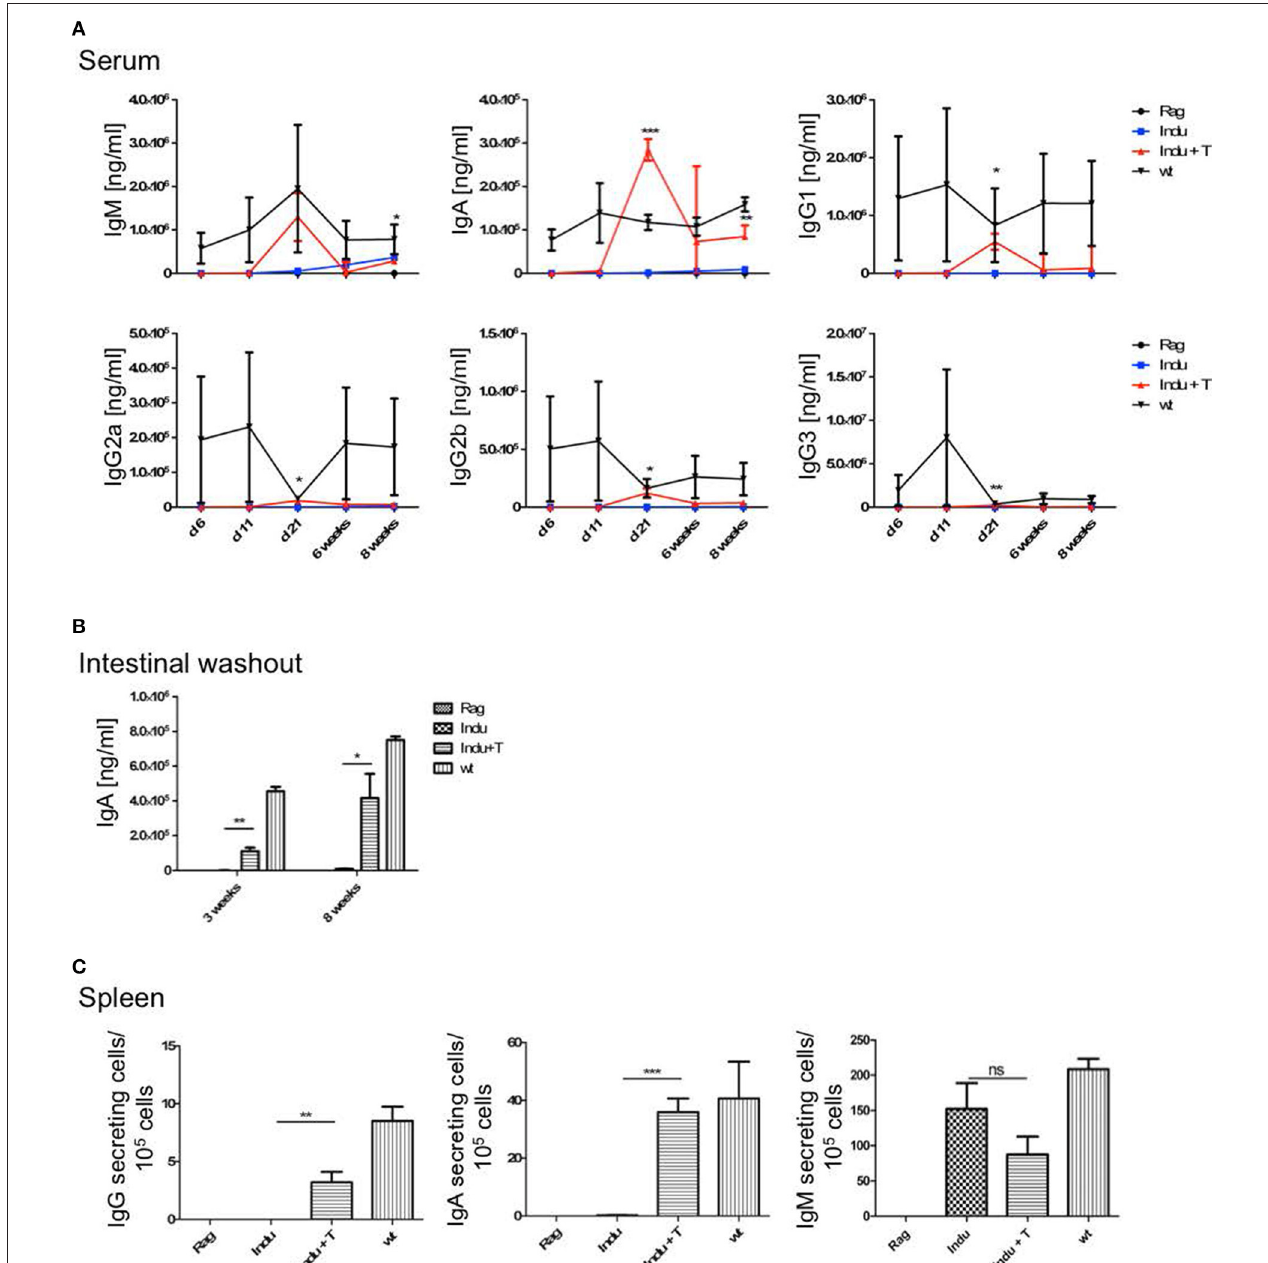
FIGURE 5 | T cell transfer enhances Ig secretion by newly generated B cells. See legends to Figures 3 , 4 for experimental details. In brief, at indicated time points after initiation of the experiment, mouse cohorts described in Figure 4 were subjected to ELISA-based Ig quantification in (A) serum ( n = 2–4 mice per group ) and (B) intestinal washout ( n = 3). (C) Number of Ig-secreting B cells determined by ELISpot. Graphs depict Ig concentrations (ng/ml) or number of Ig-producing cells as median values ± SEM; asterisks in graphs indicate the level of significance comparing “Indu” and “Indu +